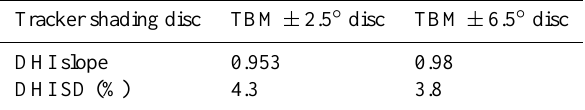
Table 7. Slopes of regression line and standard deviation of the Winster TBM vs. SPN1 DHI measurements for different opening angles. Recalibration for GHI slope applied to all readings, as